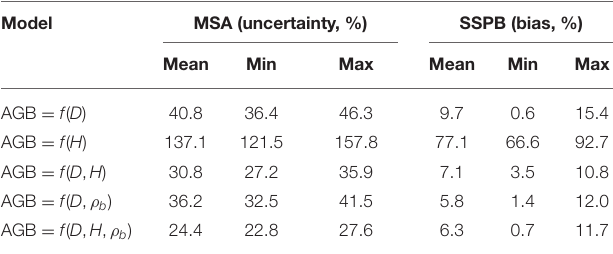
TABLE 5 | Stratified 10-fold cross-validation prediction metrics for the five models. Model MSA (uncertainty, %)